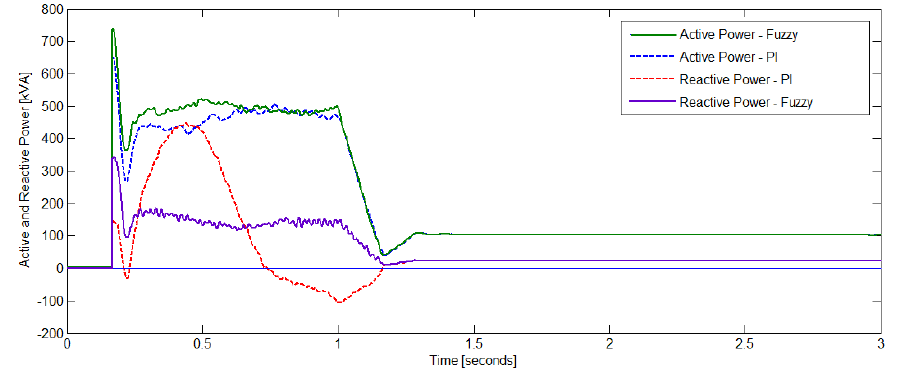
Figure 11. Active and reactive power in the case of G2V [kVA].